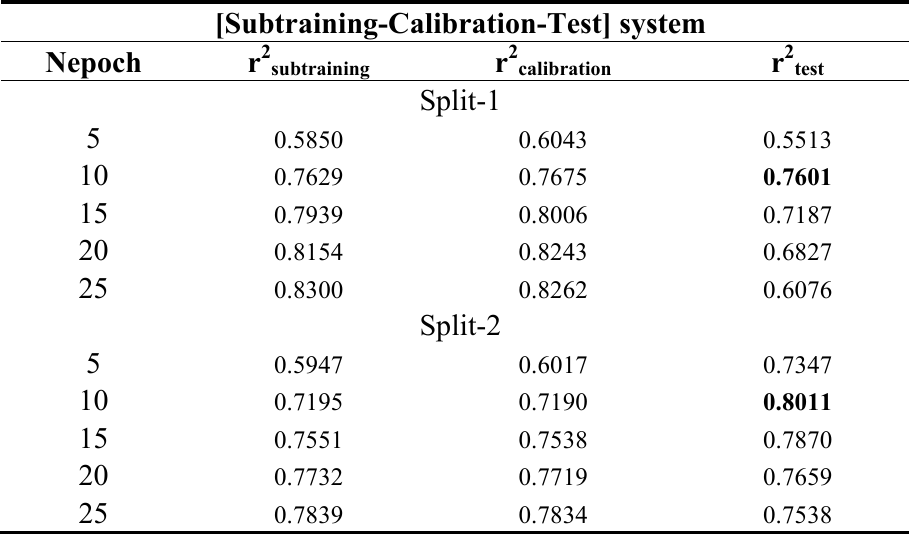
Table 3. Results of computational experiments to establish of number of epochs of the Monte Carlo optimization,